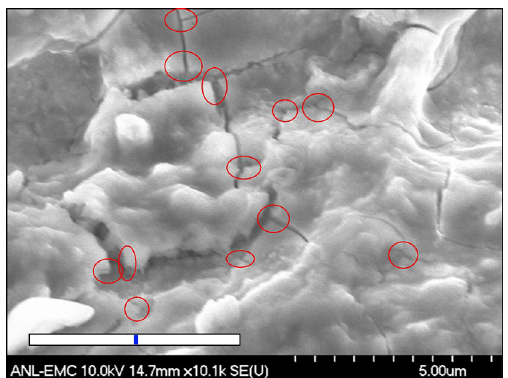
Figure 6. Many cracks visible in SEM images of the center of an arc damage spot at a magnification of × 10,100. Crack junctions where high field enhancements are expected, are noted. The widths of the cracks are caused by the thermal contraction of the material, � × ∼ × α� T ∼ 2% of the initial section, as it cools after solidifying, where α is the coefficient of thermal expansion and (cid:31) T is the change in temperature. The overall diameter of the damage is ∼ 500 µ m, which explains the wider cracks. The blue spot is 2% of length the white line for comparison. The sharp corners would have high local fields, likely sources of field emission 16,18